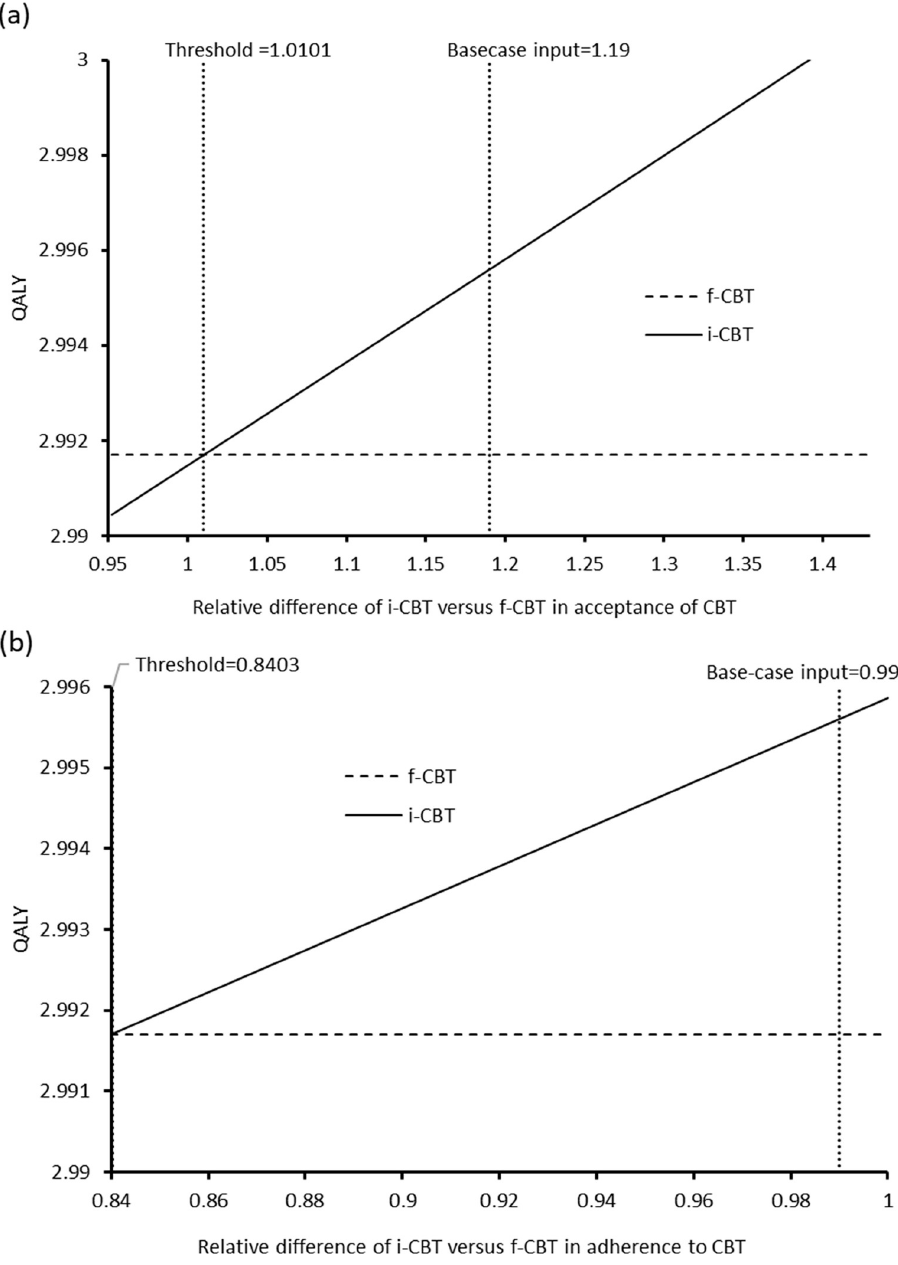
Fig 2. One-way sensitivity analysis on change of QALY against relative difference of i-CBT versus f-CBT in (a) acceptance of CBT and (b) adherence to CBT. CBT: cognitive-behavioral therapy f-CBT: face-to-face cognitive- behavioral therapy; i-CBT: internet-based cognitive-behavioral therapy; QALY: quality-adjusted life-year. against incremental QALYs gained by the i-CBT versus f-CBT were shown in a scatter plot ( Fig 4 ). When compared with the f-CBT, the i-CBT gained higher QALY by 0.00267 (95% CI 0.00262 to 0.00271, p < 0.001) with a cost-saving of US $119 (95% CI US $118 to US $120, p < 0.001). The probabilities of each strategy to be accepted as cost-effective were presented in the acceptability curves ( Fig 5 ). The i-CBT was cost-effective in 90.9% of the time at the